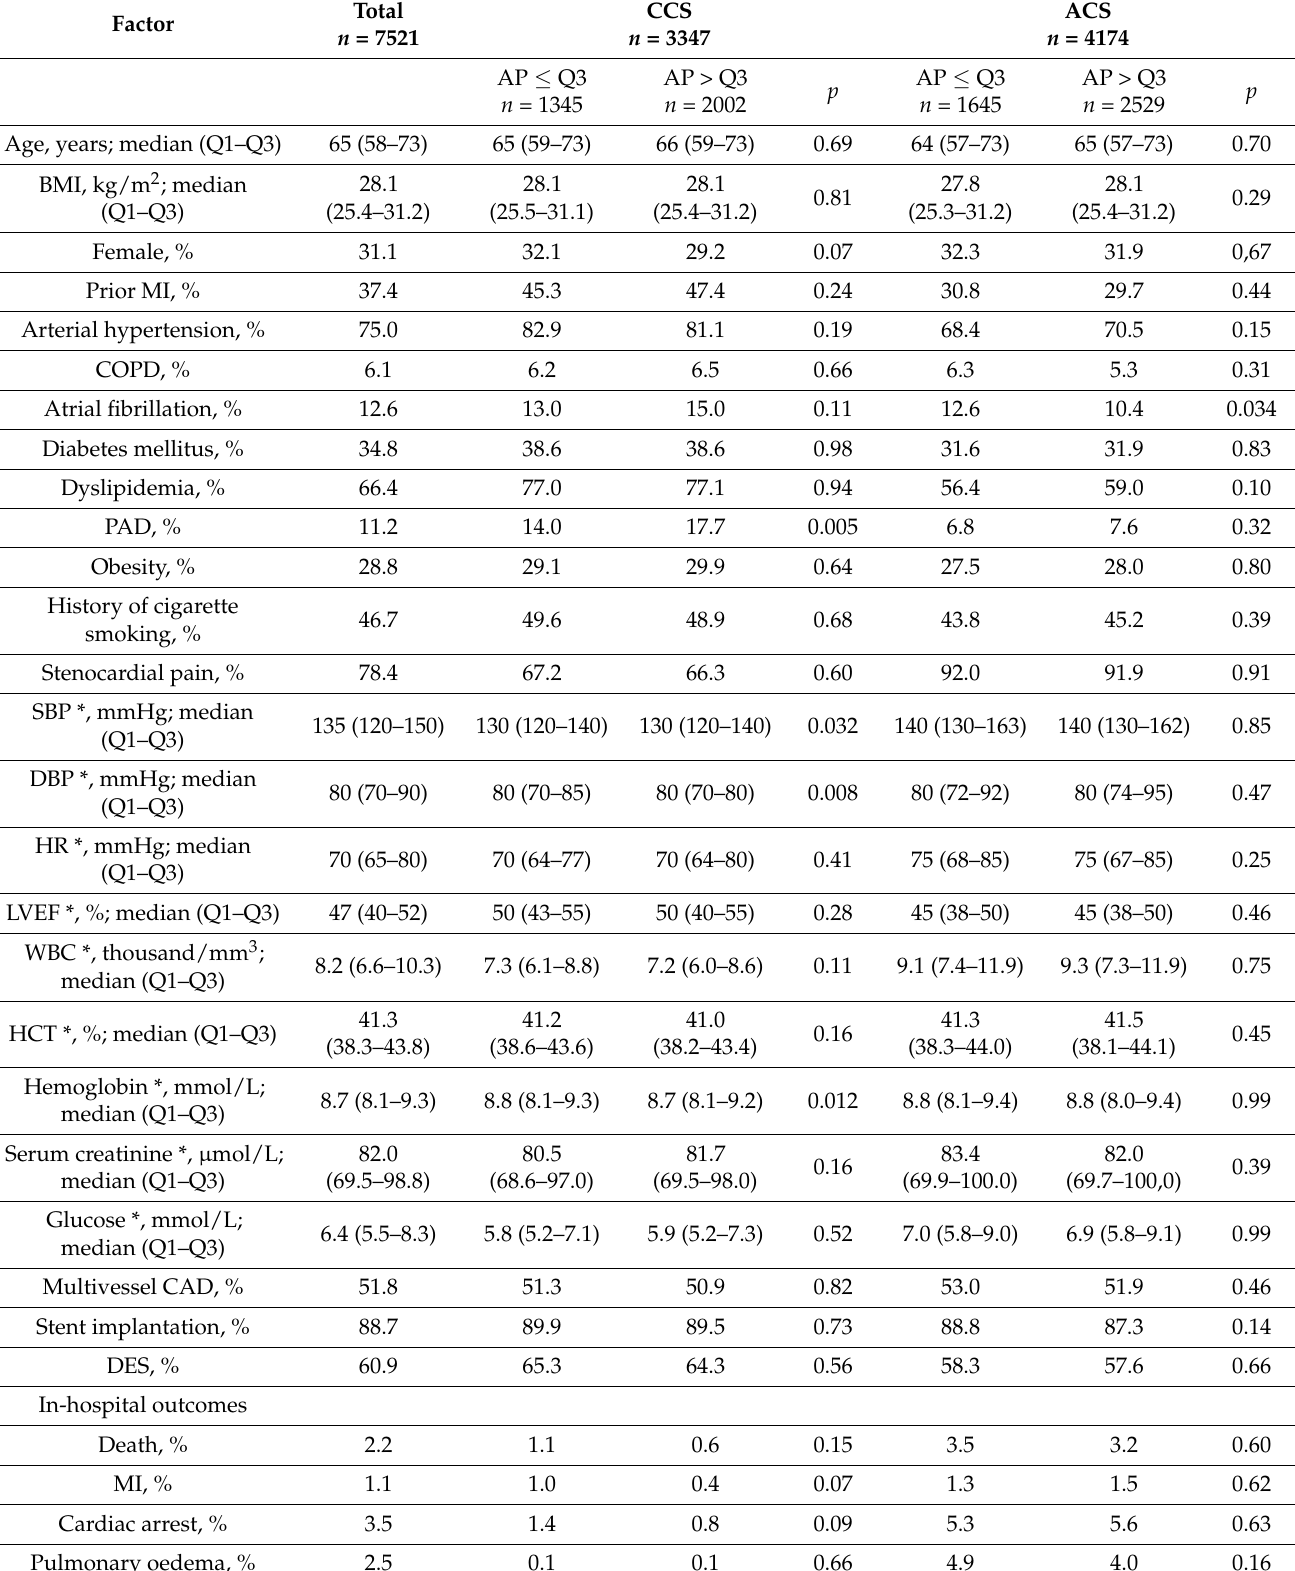
Table 1. Clinical characteristics of total sample and study